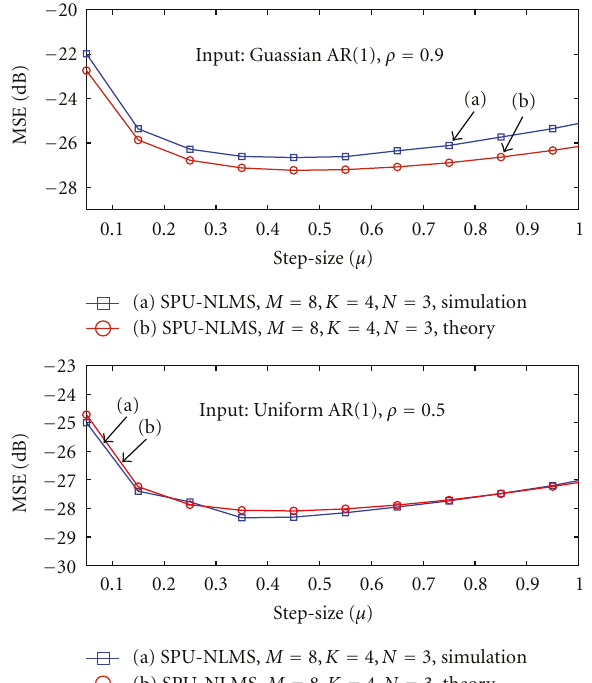
Figure 9: Steady-state MSE of SPU-APA with M = 8, P = 4, K = 4 and N = 2 as a function of the step size in nonstationary environment for di ff erent input signals.